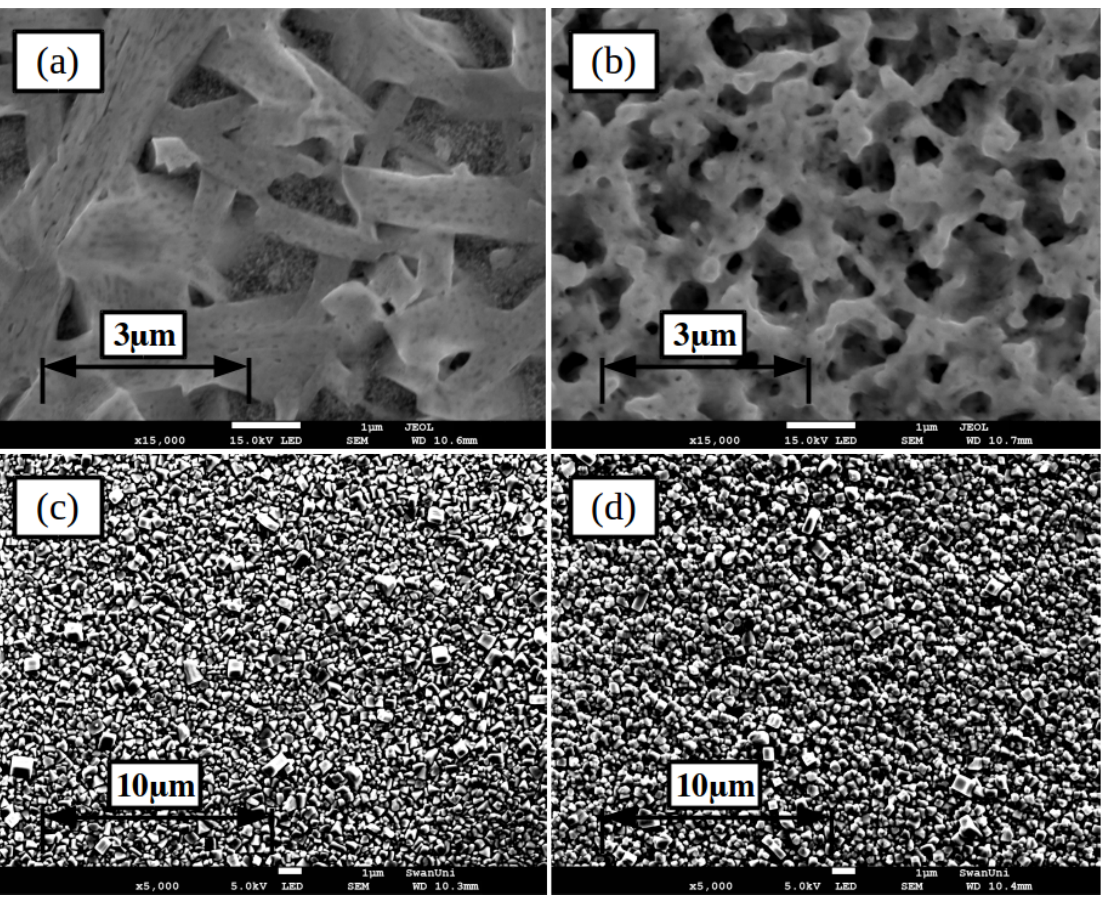
Figure 4. SEM images of lead iodide films formed from coatings of formulations based on either ( a ) DMF or ( b ) DMSO and once converted to perovskite by dip coating, ( c ) DMF and ( d ) DMSO. Inset scale-bar lengths are given in inset